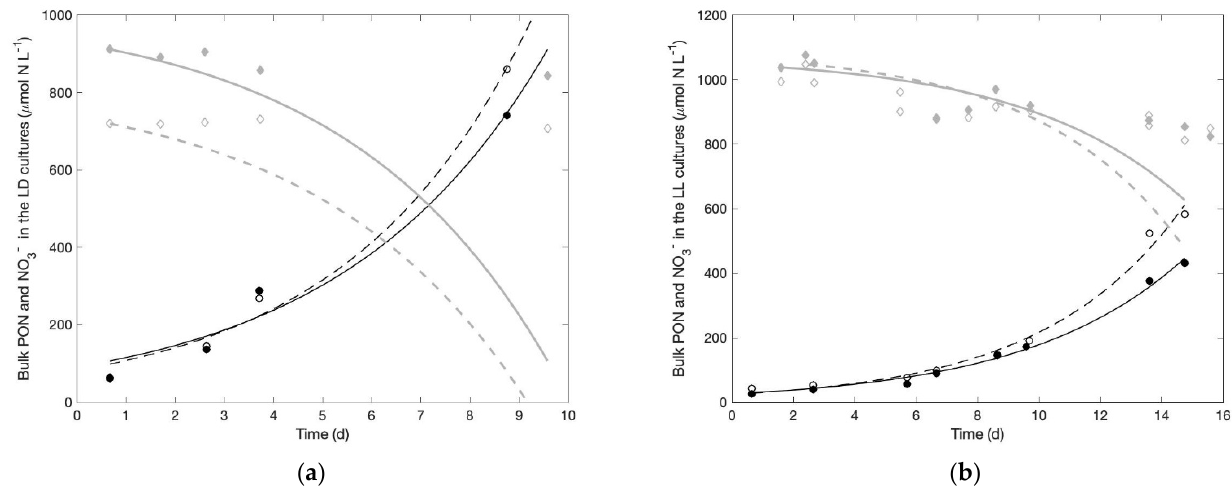
Figure 1. Measured and fitted population dynamics of Crocosphaera expressed as particulate organic nitrogen (PON, μ mol N L − 1 ) and NO 3 − concentrations ( a ) in the two LD, NO 3 − -rich culture replicates from Experiment #1 and ( b ) in the two LL, NO 3 − -rich culture replicates from Experiment #2. Measured biomass concentration (closed and open black circles) ( μ mol N L − 1 ) and the corresponding, measured nitrate concentrations (closed and open grey diamonds) in the cultures. Black lines (continuous and dashed) represent the fitted cell biomass and thick grey lines (continuous and dashed) the predicted changes in NO 3 − concentration that would result from a growth entirely supported by NO 3 − uptake.